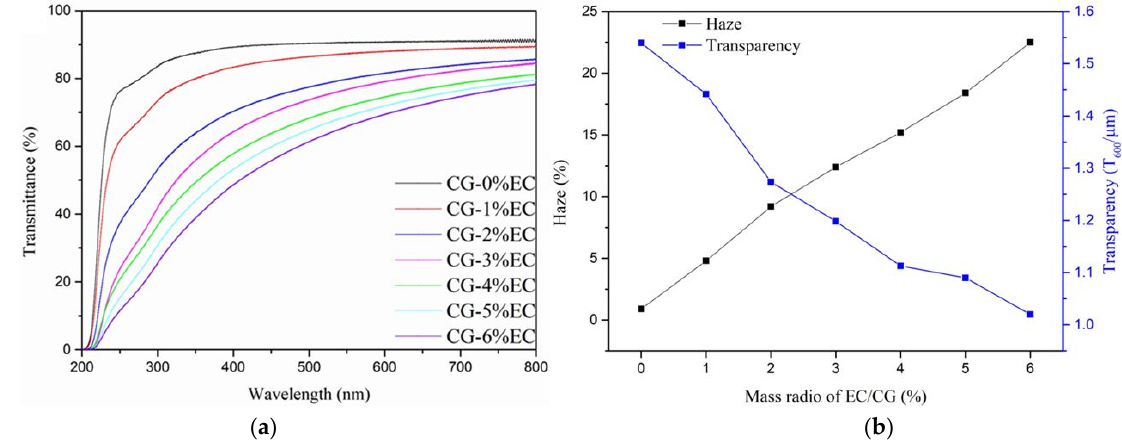
Figure 6. The light transmittance ( a ) and haze and transparency ( b ) of the films.